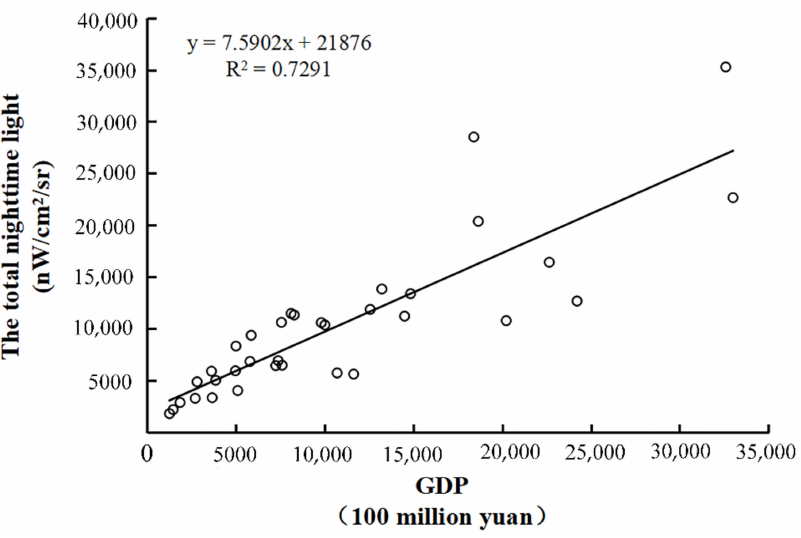
Figure 3. Scatter plot of the total NTL value and city GDP.